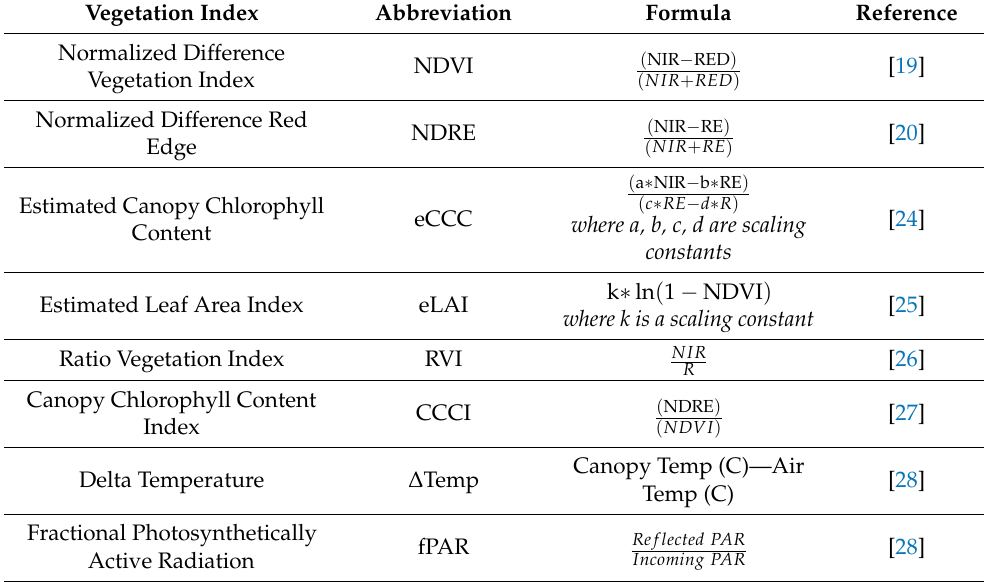
Figure 1. Wells research site experimental design with four replicates of block resolution drainage treatments and sub-plot tillage and sub-sub plot pre-plant N treatments. Green plots signify pre-plant N treatments while purple plots are timing treatments outside the realm of this study. NT, ST, and CT stand for no-till, strip-tillage, and conventional-tillage, respectively. The numbers for the pre-plant N treatment plots indicate the N rates (kg ha − 1 ). Table 1. List of sensor parameters calculated using the Crop Circle